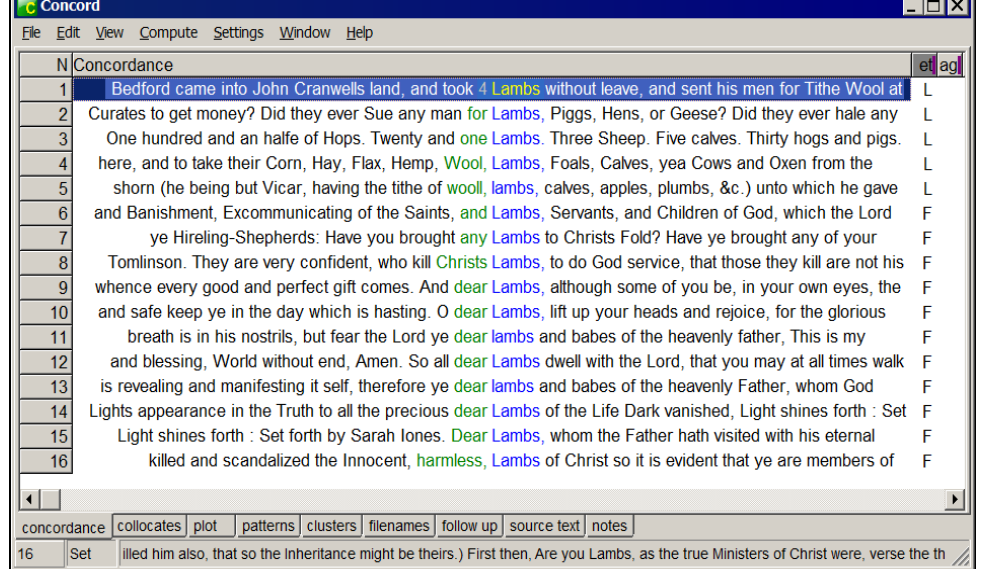
Table 3. Results of search queries of collocations relating to the items power and spirit(s). Negative Collocations Positive Collocations power